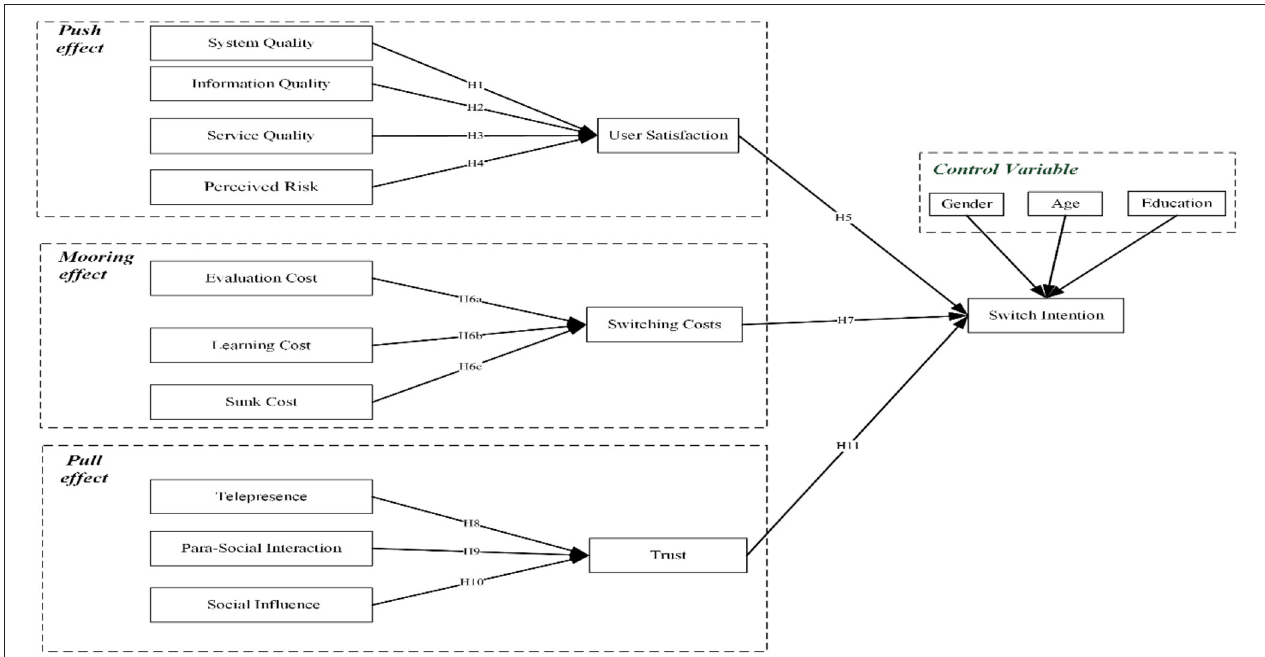
FIGURE 1 | Research